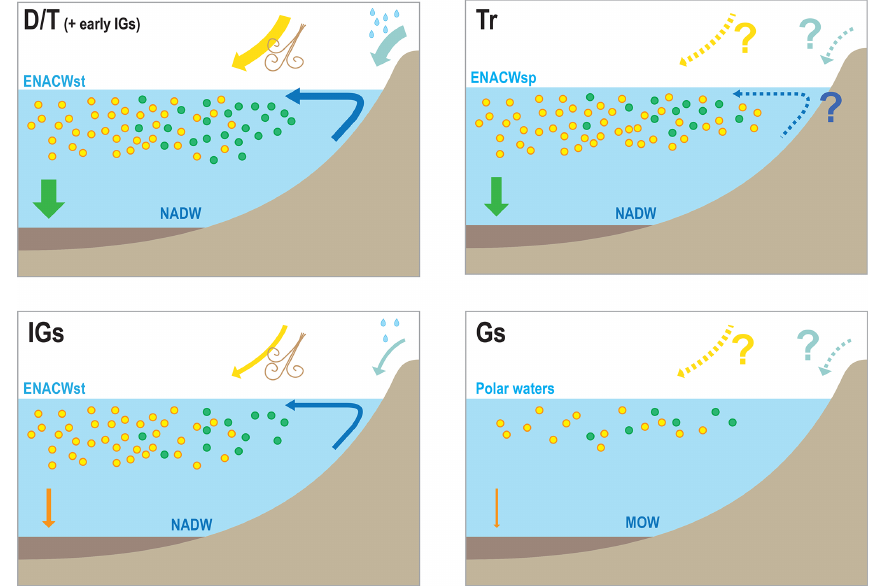
Figure 7. Conceptual models for the IbM of the different components of the carbon/carbonate cycle under different climatic scenarios: D / T, Tr, IGs, and Gs stand for deglaciation/termination, transition from interglacial to glacial substages, interglacial substages, and glacial substages, respectively; ENACWst, ENACWsp, NADW, and MOW stand for Eastern North Atlantic Central Water of subtropical or sub- polar origin, North Atlantic Deep Water, and Mediterranean Outflow Water, respectively. In the deglaciation scenario we depict increased surface productivity, associated with peaks of diatom and intermediate levels of coccolithophore productivity, and the largest marine snow export. Interglacial substages depict a decreased surplus of nutrients from terrigenous input, a decreased abundance of diatoms, and an in- termediate levels of coccolithophore productivity due to the prevalence of ENACWst origin and a large decrease export; Transitions show a general increase in phytoplankton but placing more emphasis on coccolithophores because of the increasing and persistent predominance of ENACWsp origin, with intermediate levels of export. Glacial substages show a general decline in the phytoplankton associated with export minima and the increased influence of